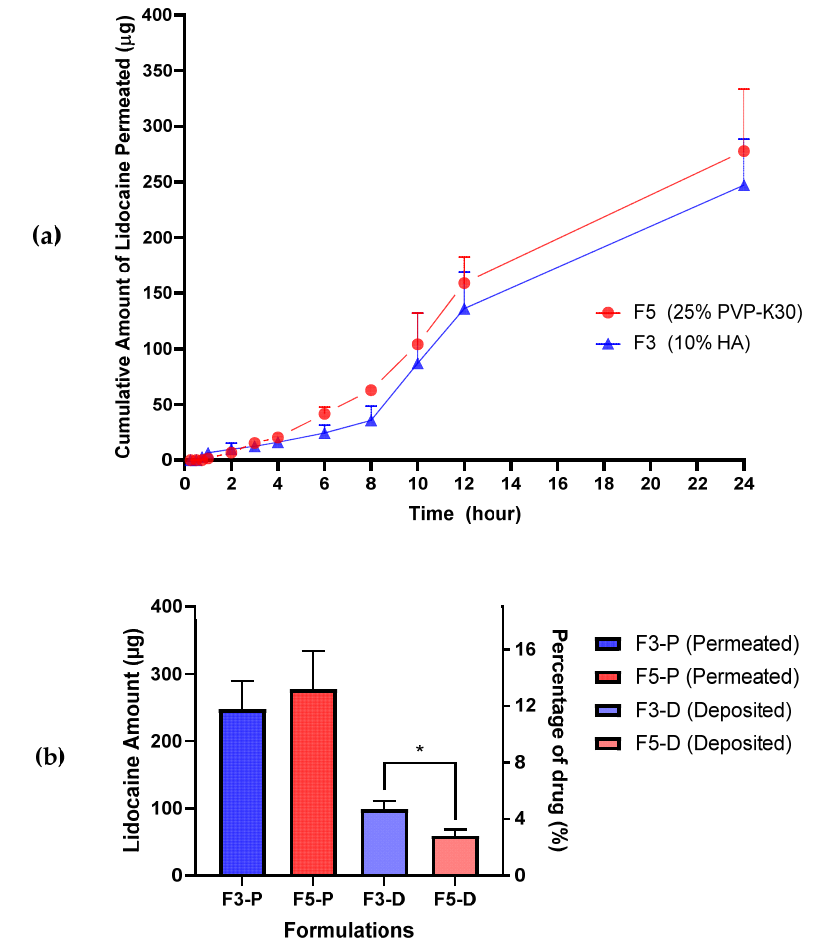
Figure 5. The LiH amount of ( a ) cumulative permeation in 24 h; ( b ) the comparison of the deposited and permeated based on in vitro study. Data are presented as means + SD (n = 3; *: p < 0.05).